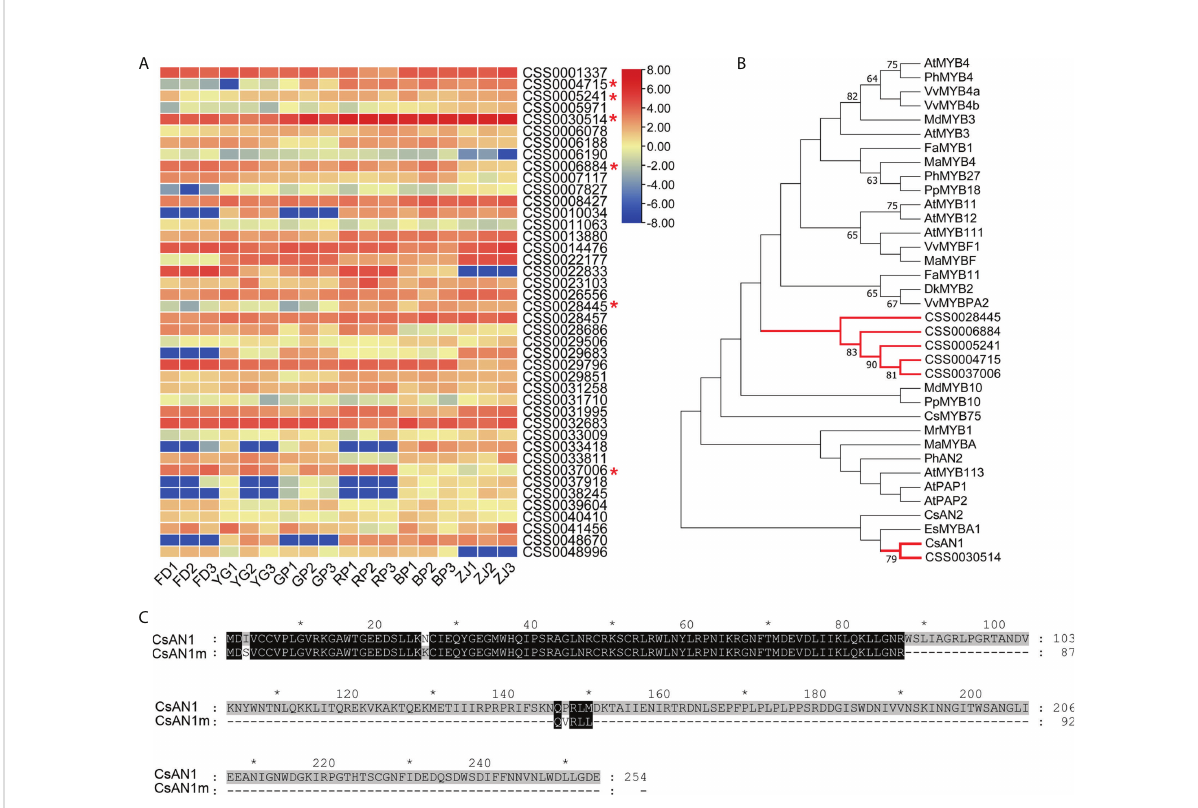
FIGURE 6 Identi fi cation of the MYB family members. (A) Heat map description of the expression patterns of MYB family members in parents and F1 hybrid progenies (the candidates of MYB family gene were marked by red "*"); (B) Phylogenetic analysis of candidate MYB family members; (C) Sequences alignment of CsAN1 (Gene bank accession: KU745295) and putative protein encoded by CsAN1m (CSS0030514) (the gray ‘ * ’ means the numbers spaced by